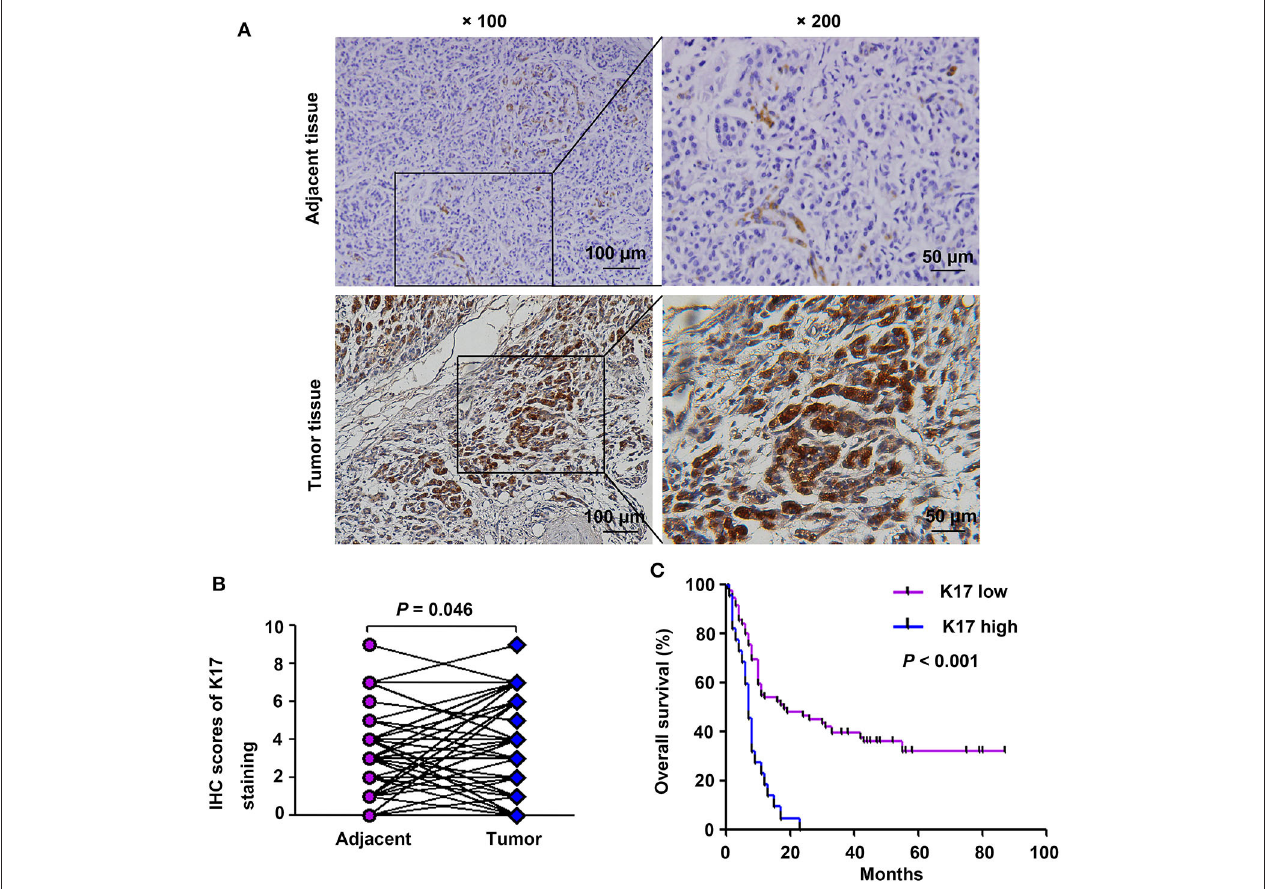
FIGURE 2 | K17 protein expression was associated with poor clinical outcome in pancreatic cancer patients. (A) Representative immunohistochemical staining of K17 in pancreatic cancer tissues and adjacent normal tissues; × 100, scale bar = 100 µ m; × 200, scale bar = 50 µ m. (B) Comparison of total scores of K17 protein in pancreatic cancer tissues and their matched adjacent normal pancreatic tissues ( n = 51 pairs). (C) The overall survival rate of patients with pancreatic cancer was evaluated based on K17 expression and determined using Kaplan-Meier analysis ( n = 94).